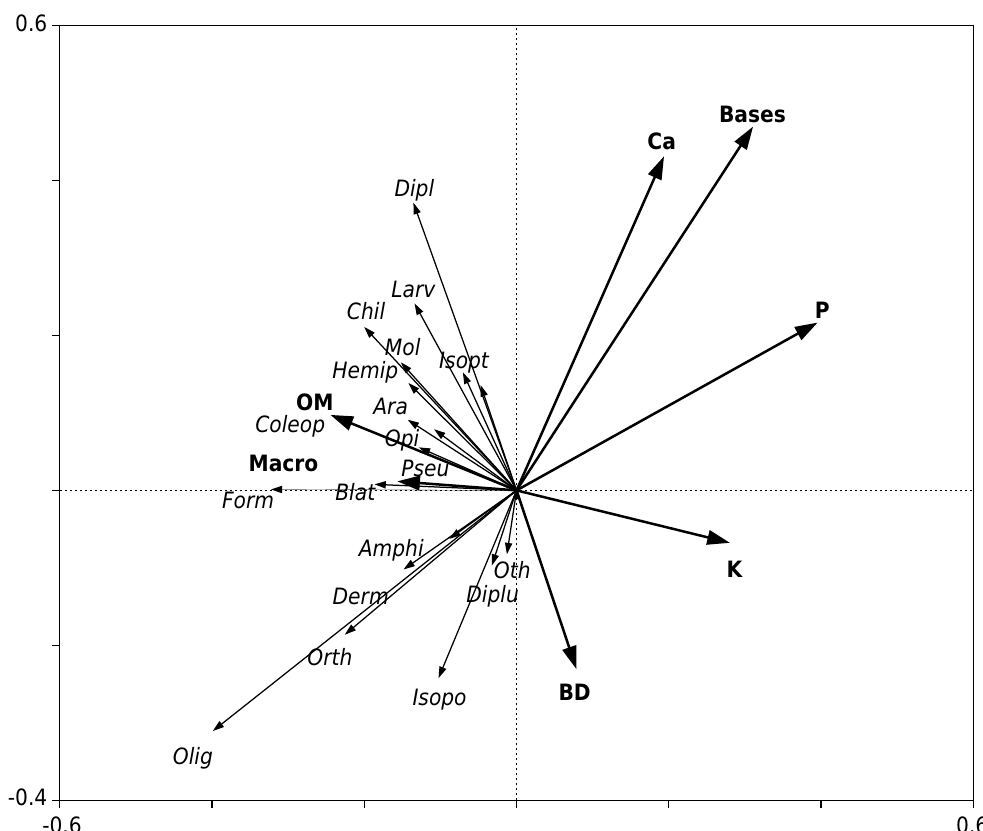
Figure 7. Redundancy analysis (RDA) for macrofaunal groups (in italics) and soil physical and chemical properties (in bold) in the summer sampling in the eastern region of Santa Catarina, Brazil. Oligochaeta ( Olig ), Formicidae ( Form ), Coleoptera ( Coleop ), Opiliones ( Opi ), Dermaptera ( Derm ), total of other larvae ( Larv ), Molusca ( Mol ), Pseudoscorpionidae ( Pseu ), Diplopoda ( Dipl ), Chilopoda ( Chil ), Isopoda ( Isopo ), Araneae ( Ara ), Blattodea ( Blat ), Diplura ( Diplu ), Isoptera (Isopt), Orthoptera ( Orth ), Amphipoda ( Amphi ), total of other less frequent groups ( Oth ). Chemical properties: phosphorus (P), calcium (Ca), potassium (K), base saturation (Bases), organic matter (OM), and physical properties: macroporosity (Macro) and bulk density (BD).